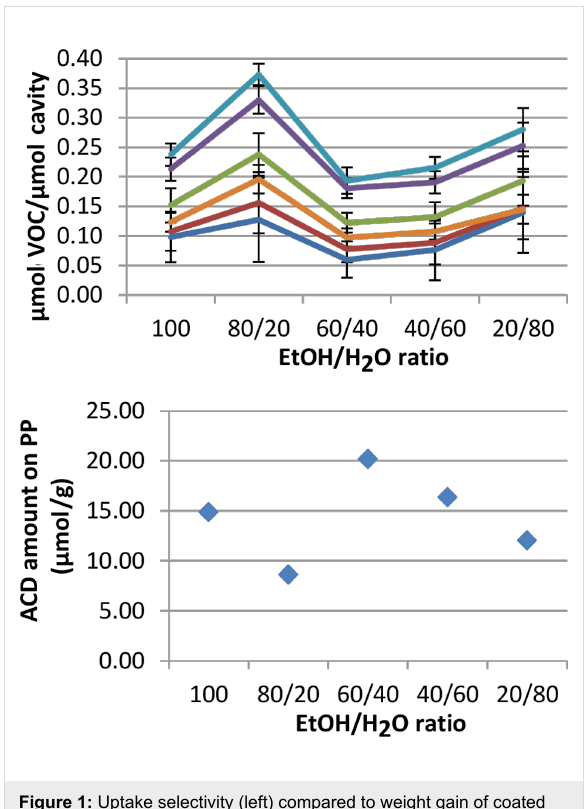
Figure 1: Uptake selectivity (left) compared to weight gain of coated polypropylene (right) exemplified by a coating of ACD 2 . Standard deviation ( n = 3) indicated by the error